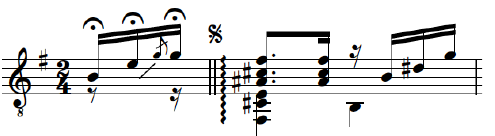
Figure 7. Excerpt of the Choros № 1 score (until the end of the first complete bar).